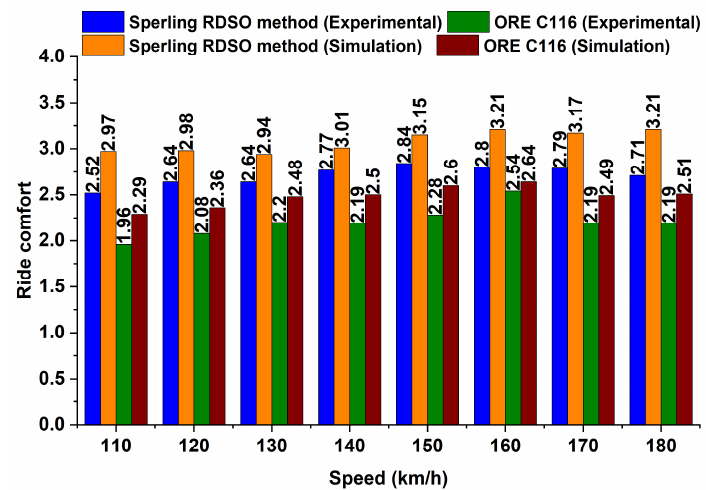
Figure 4. Comparison of numerical and experimental analysis for empty condition.